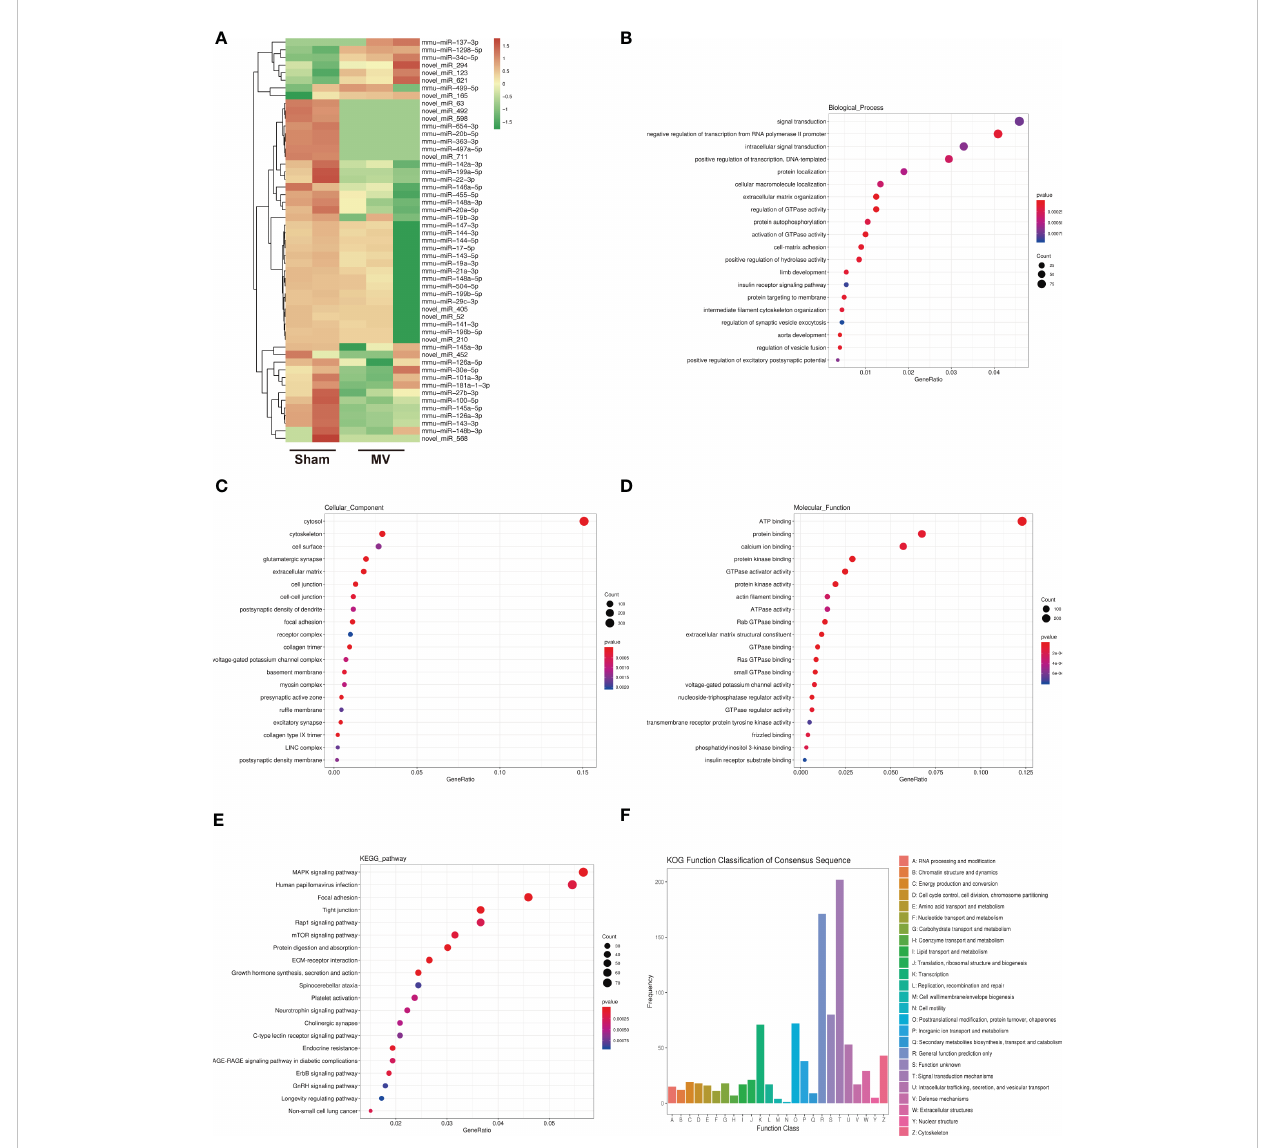
FIGURE 2 Heatmap of miRNA expression and Enrichment Analysis of differentially expressed miRNA-targeted mRNA (A) . heatmap differentially abundant miRNA in the BALF-EV isolated from Sham and MV mice. (B-D) . Target genes of differentially expressed miRNA as determined by GO annotation. (E) . KEGG pathway analysis of differentially expressed miRNA-targeted mRNA. (F) . KOG functional classi fi cation of differentially expressed miRNA- targeted